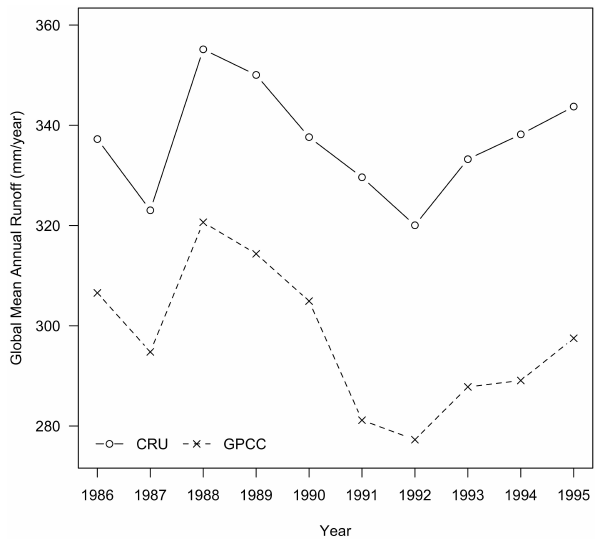
Fig. 2. Comparison of LPX global mean annual runoff for 1986– 1995 using CRU TS 3.0 and GPCC precipitation input